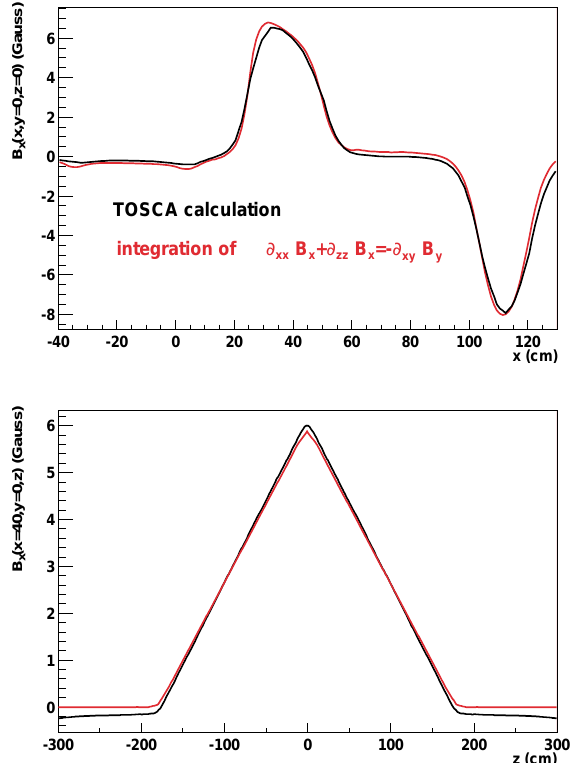
FIG. 3. (Color) TOSCA calculation of B x compared with the re- sults of a simulated measurement of ≠ xy B y and subsequent in- tegration of Eq. (12).